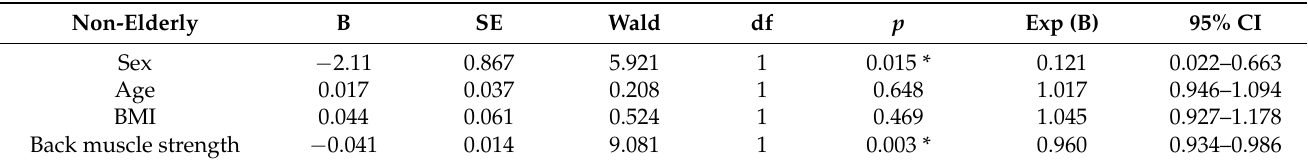
Table 3. Logistic regression analysis for risk factors of low visual acuity (L group) in non-elderly